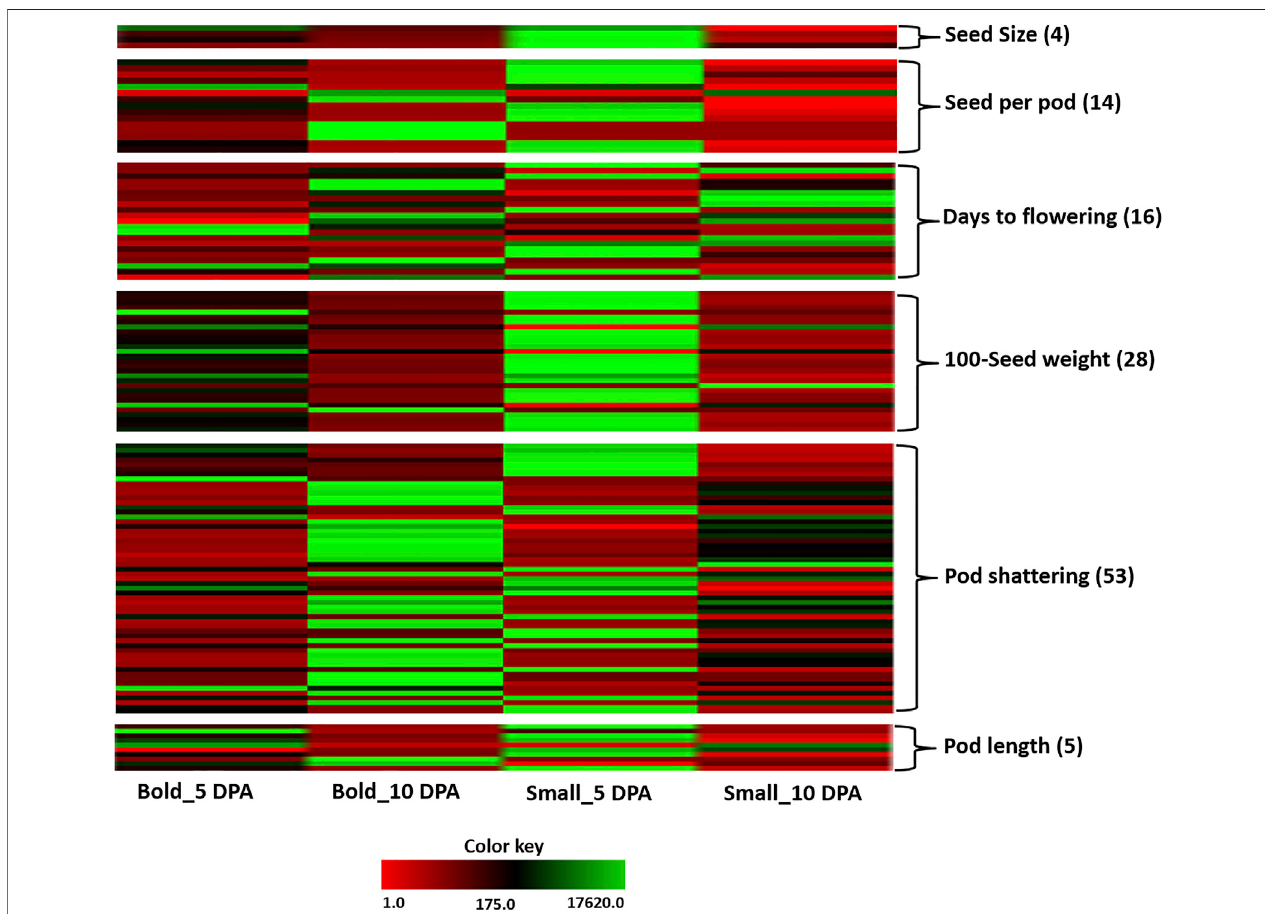
FIGURE 9 | Heat map representing the differential gene expression of the identi fi ed candidate genes for six traits including seed size, 100-seed weight, seed/pod, days to fl owering, pod shattering, and pod length in bold and small genotypes at 5 DPA and 10 DPA.